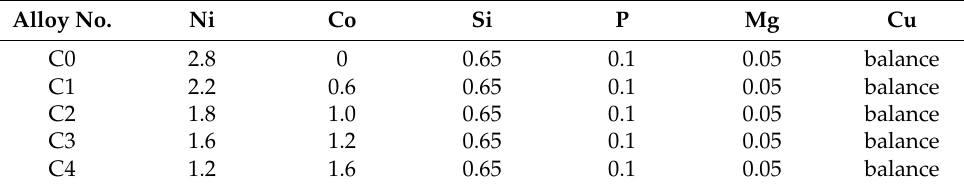
Table 2. Nominal Chemical compositions of Cu-Ni-Co-Si-P-Mg alloys (wt.%). Alloy